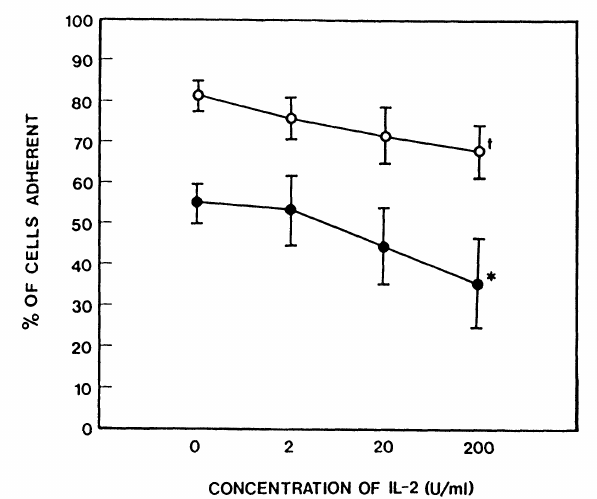
FIG. 1. Phagocyte adherence to dacron fibre decreased with increasing IL-2 concentrations. Final cell concentration was 5 106 ml. Neutrophils (0) and monocytes (O) both demonstrate decreased adherence at 200 U/ml IL-2. p < 0.01, p < 0.02.